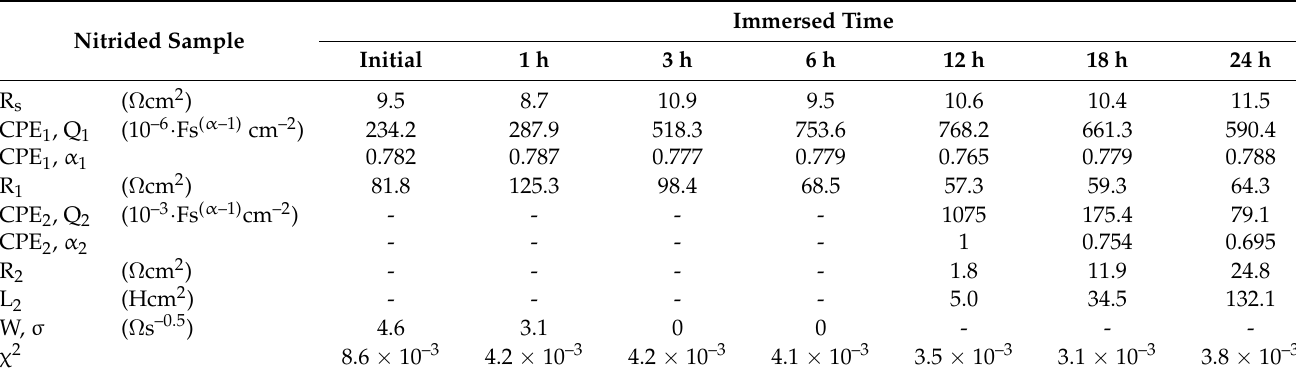
Table 6. EIS parameters for the sample nitrided with f N2 of 0.5.